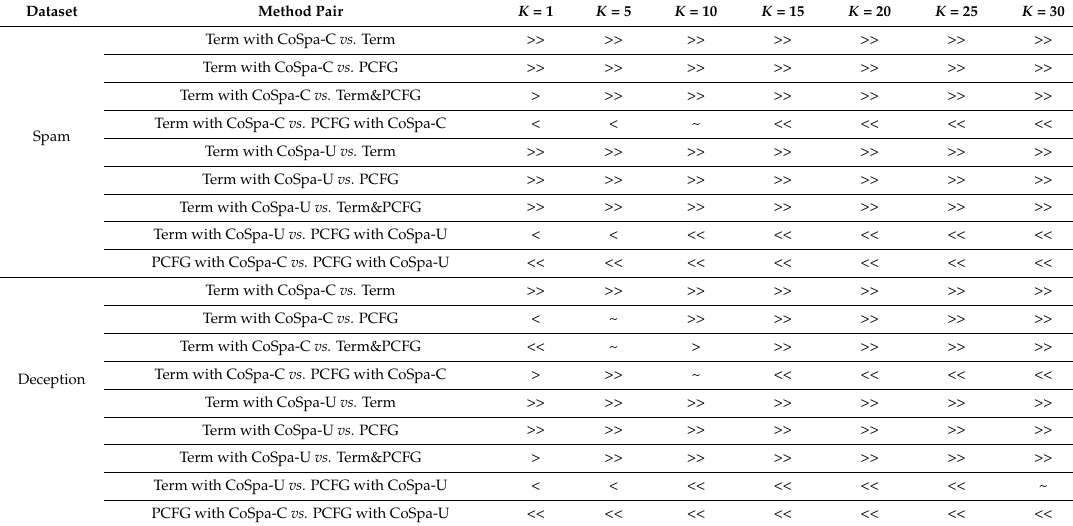
Table 7. The performances on accuracies of the CoSpa algorithm compared with the state-of-the-art methods on spam review identification in the spam and deception